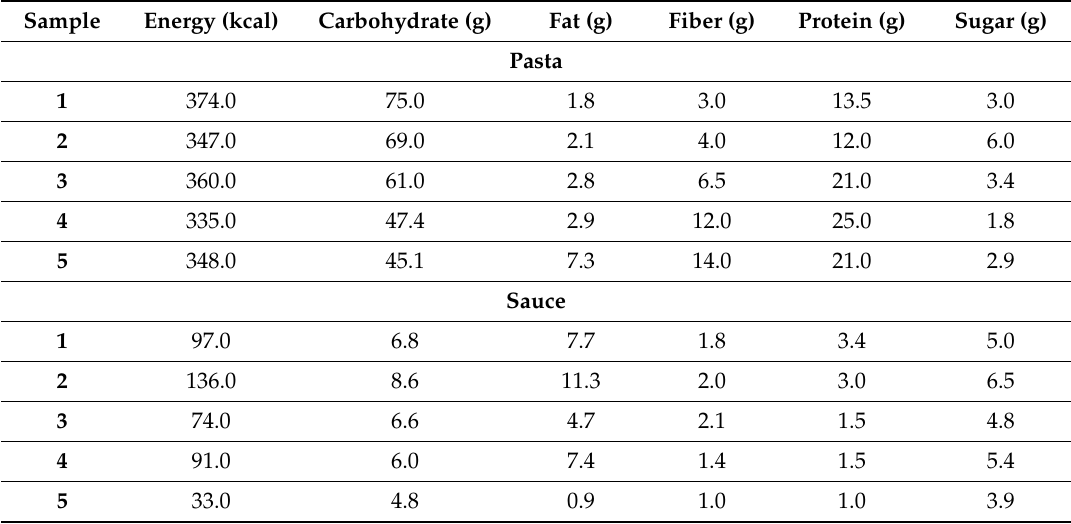
Table 1. Nutritional parameter values calculated for 100 g of dry pasta and 100 g of sauce.